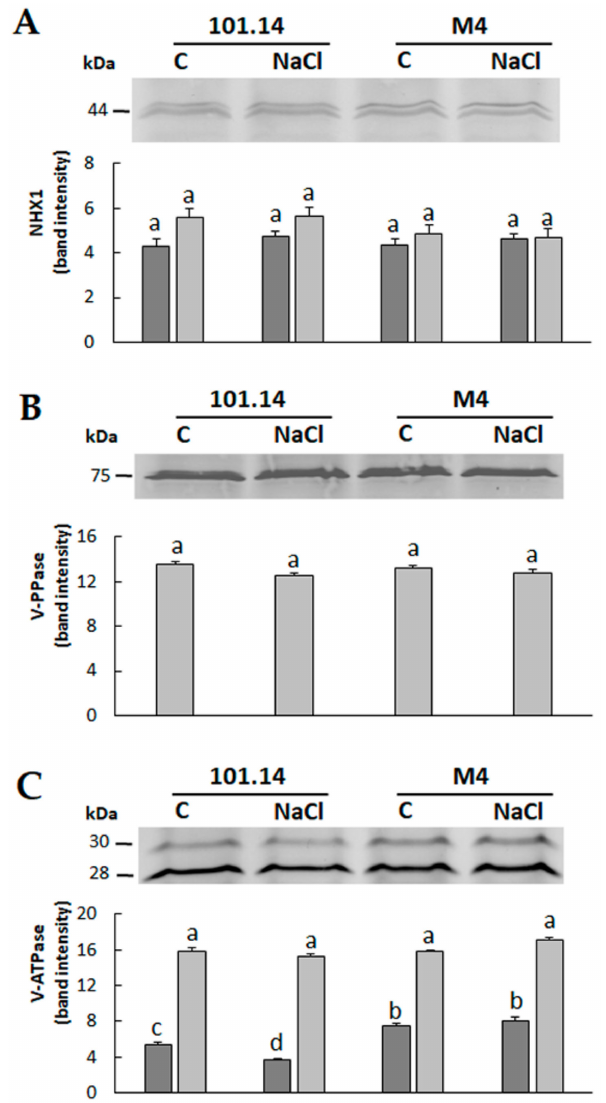
Figure 2. Western blot (WB) analyses of the NHX1 ( A ), V-PPase ( B ) and subunit E of V-ATPase ( C ) extracted from roots of 101.14 and M4 grapevine rootstocks grown for 21 days in control (C) or salt stress (NaCl) conditions. When two bands were detected, dark-grey bars refer to the band with higher MW, while light-grey bars to the band with lower MW. The intensity of bands described by the histograms was quantified by densitometric analysis with ImageJ. The values are the means ± Standard Error (SE) of three independent WB analyses ( n = 3). The statistical significance was assessed by analysis of variance (ANOVA) test ( p < 0.05, Tukey post hoc